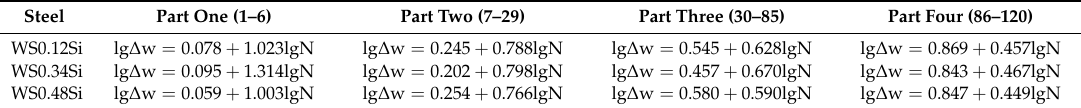
Table 2. Corrosion weight gain fitting